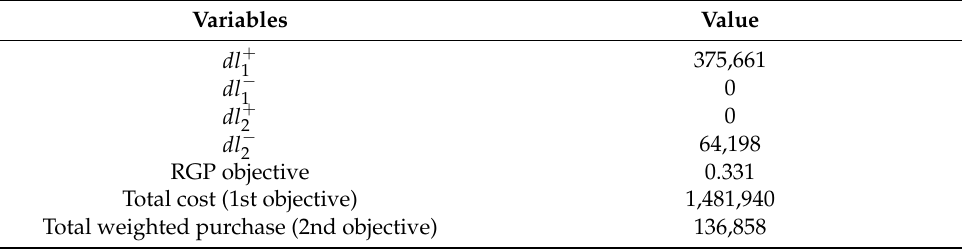
Table 10. Output